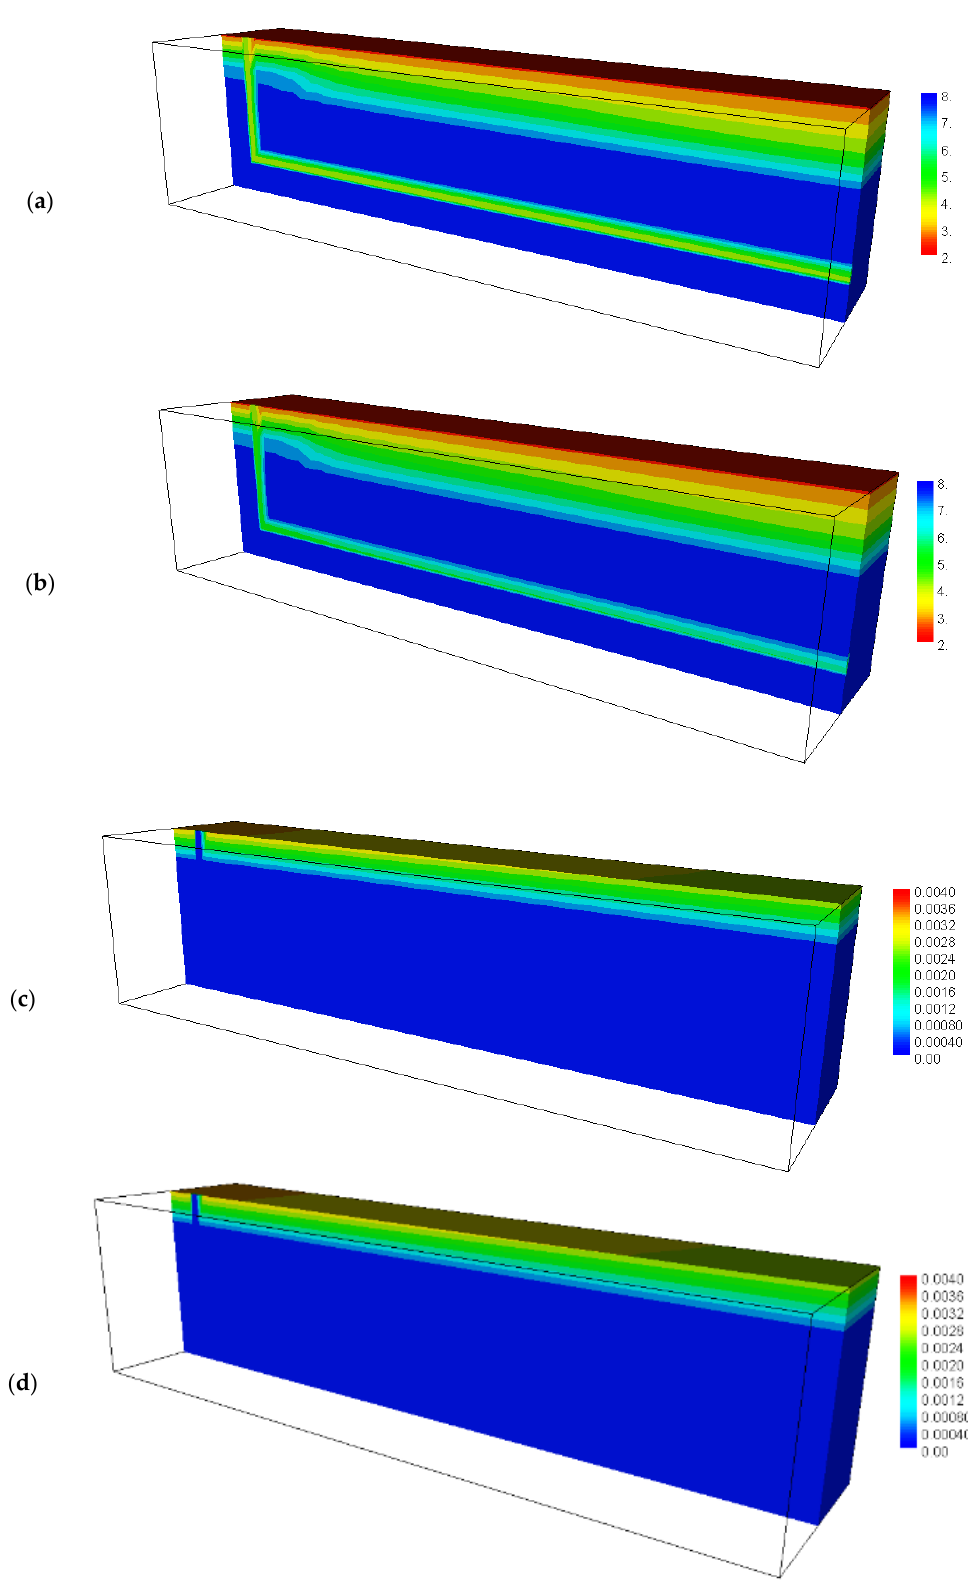
Figure 7. Distribution of the pH and total iron concentration after backfilling at t = 50 years (case 2-1 and case 2-2): ( a ) pH (case 2-1), ( b ) pH (case 2-2), ( c ) total iron concentration (mol/L) (case 2-1), and ( d ) total iron concentration (mol/L) (case 2- 2).